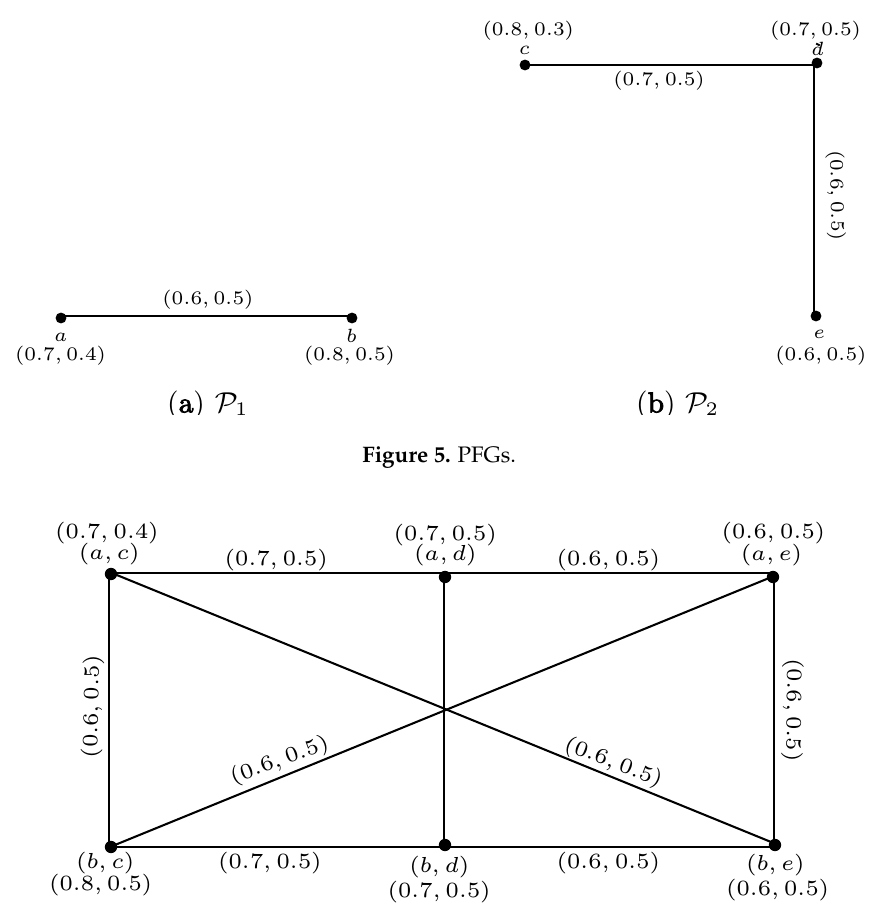
Figure 2.4: PFGs. Figure 5. PFGs.